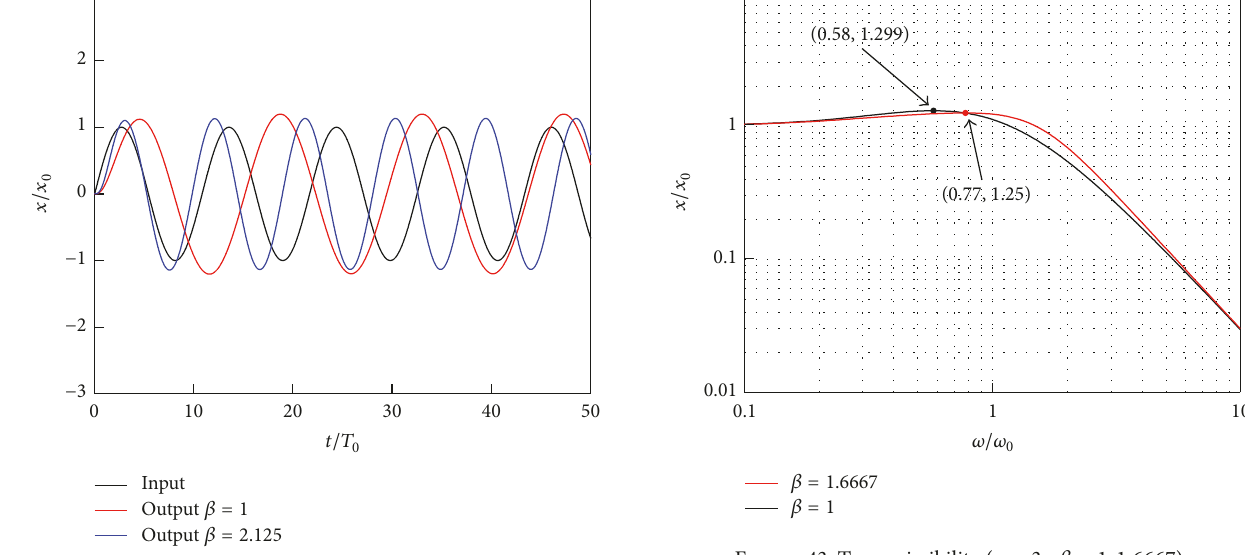
Figure 43: Transmissibility ( 𝛼 = 3, 𝛽 = 1, 1.6667 ).